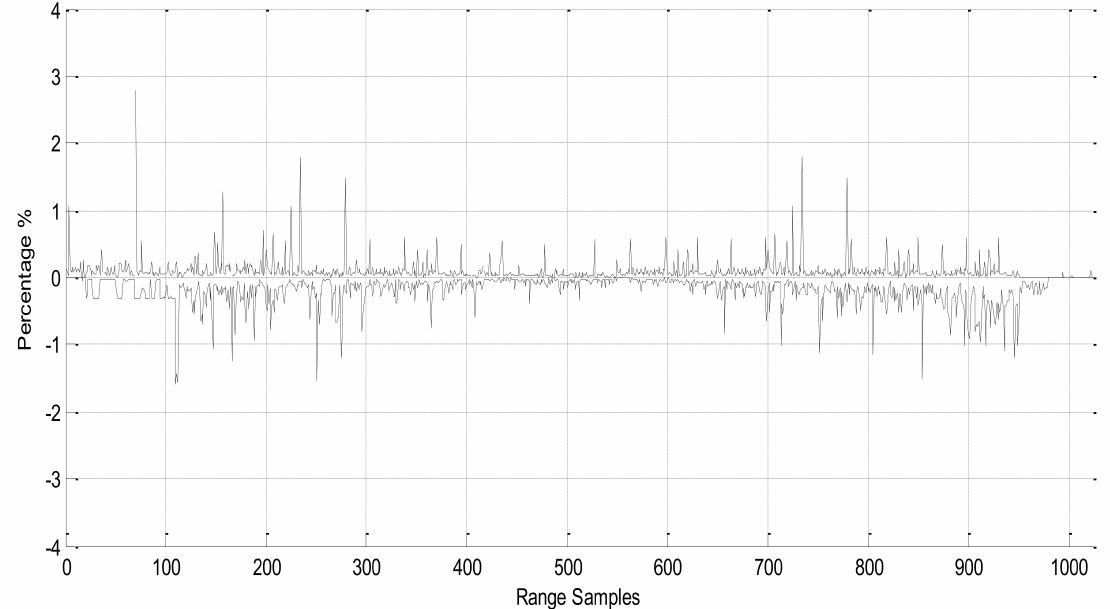
Figure 13. Difference in range-compressed data (range profile) in the range-Doppler domain (range time, azimuth